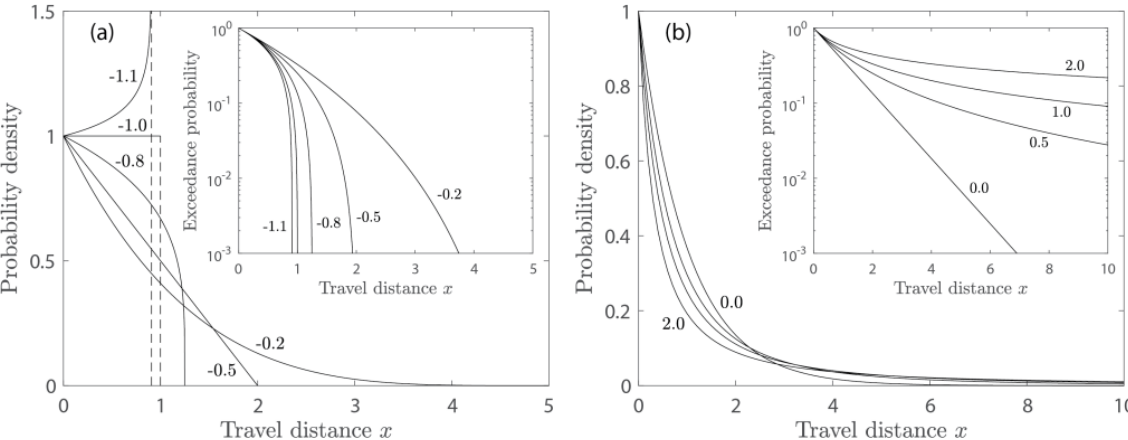
Figure 2. Plot of the generalized Pareto distribution of particle travel distances x for scale parameter B = 1 and different values of the shape parameter A with (a) A < 0 representing rapid thermal collapse and (b) A ≥ 0 with associated exceedance probability plot (inset) representing net heating of particles. Compare with Fig. 1 in Hosking and Wallis (1987).